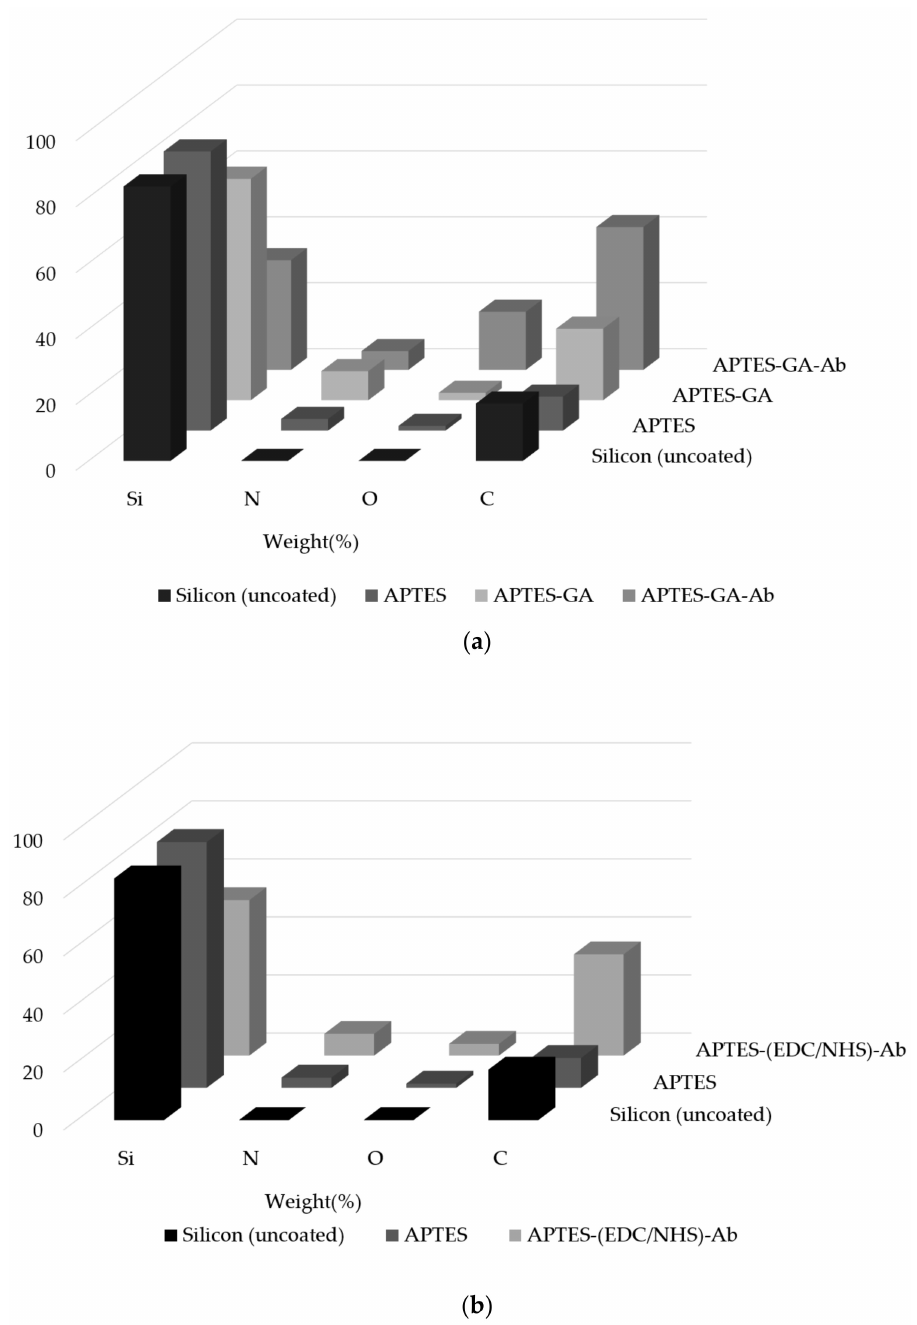
Figure 10. Element composition after each step of anti-TNF-alpha coating using ( a ) APTES-GA technique and ( b ) APTES- (EDC/NHS)